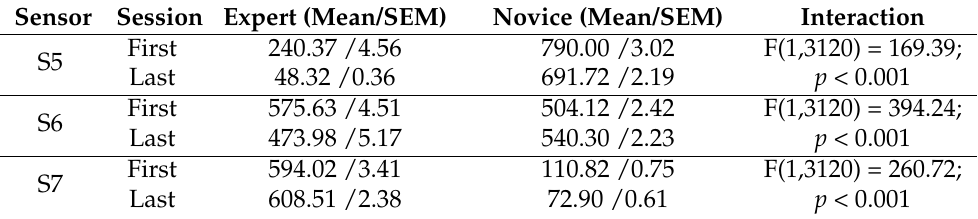
Table 9. Two-way ANOVA on three sensors on dominant hand of expert and novice for the first and last session